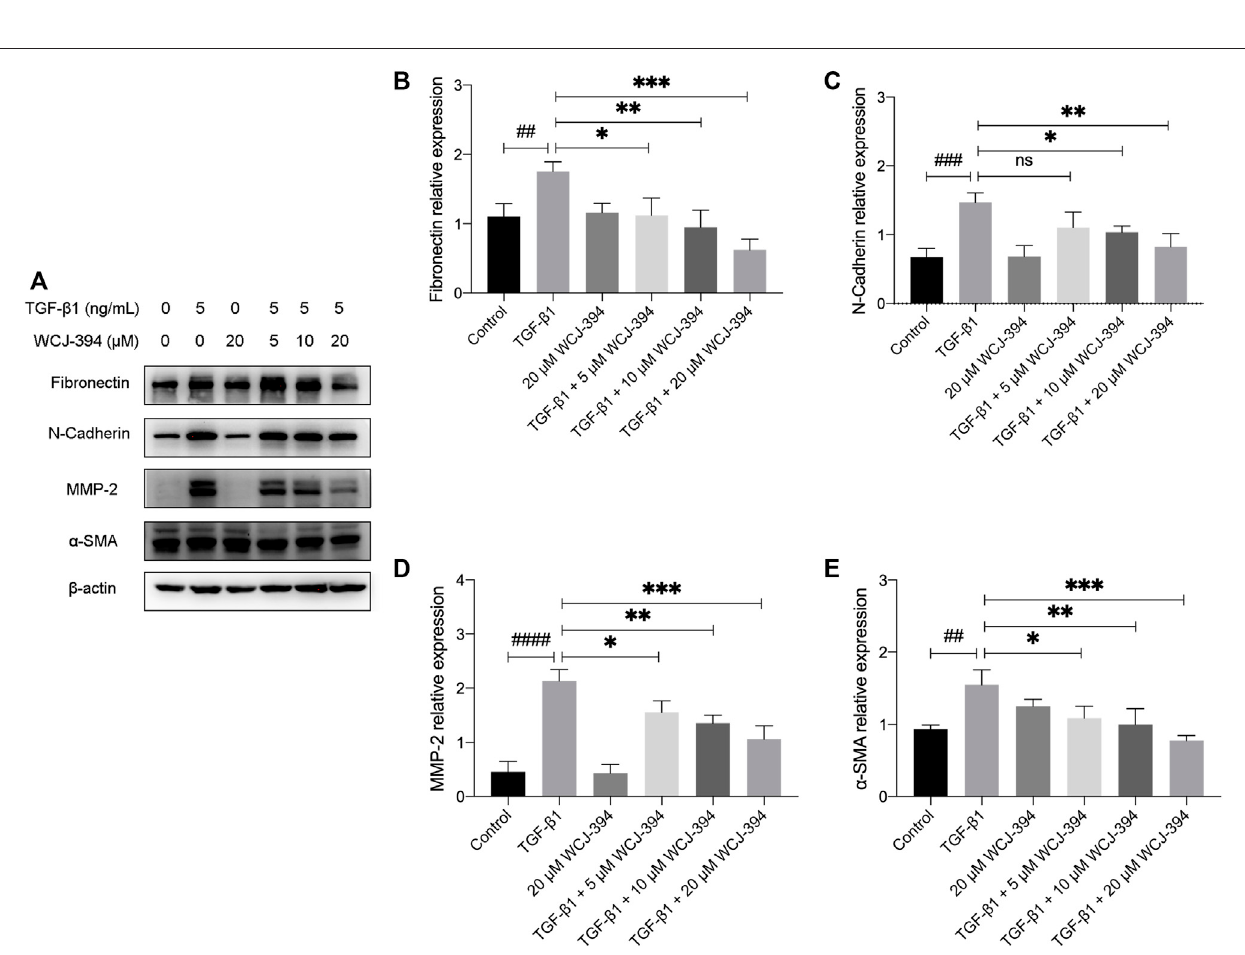
Frontiers in Chemistry |